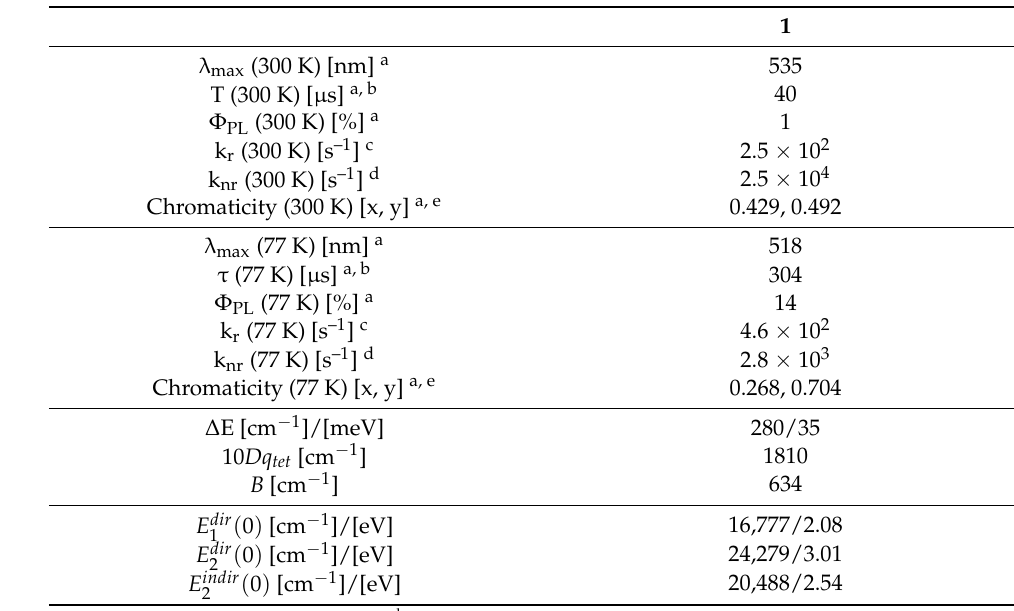
Figure 2. Temperature dependences—of the photoluminescence excitation spectra of ( 1 ) : ( a ) λ Em = 538 nm, ( b ) λ Em = 670 nm ; and of its photoluminescence spectra ( c ) λ Ex = 455 nm.